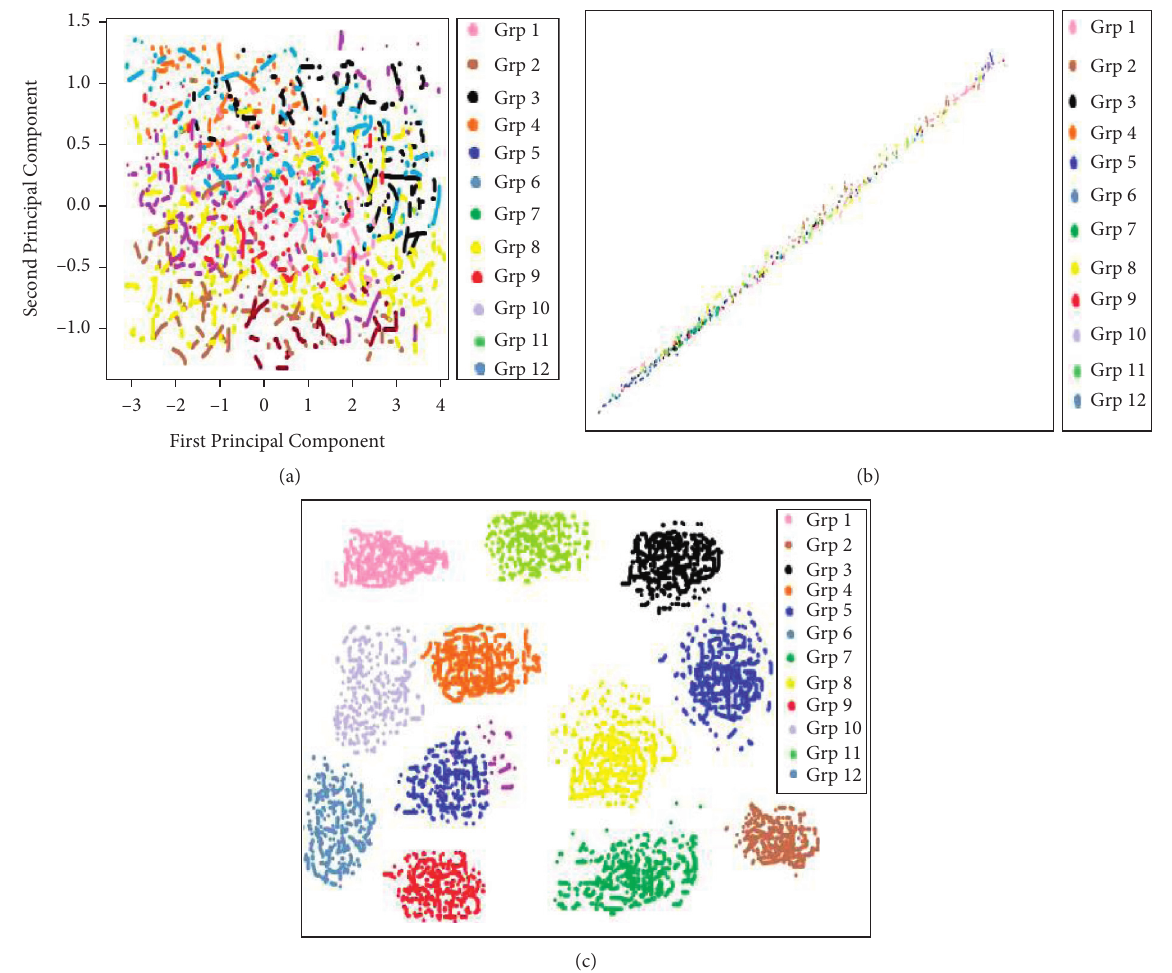
Figure 11: Thevisualization results ofthehigh-dimensionalfusion matrixdataofthe Urduhandwritten Urdu charactersusing(a)Autoencoders, (b) Principal component analysis, and (c) t